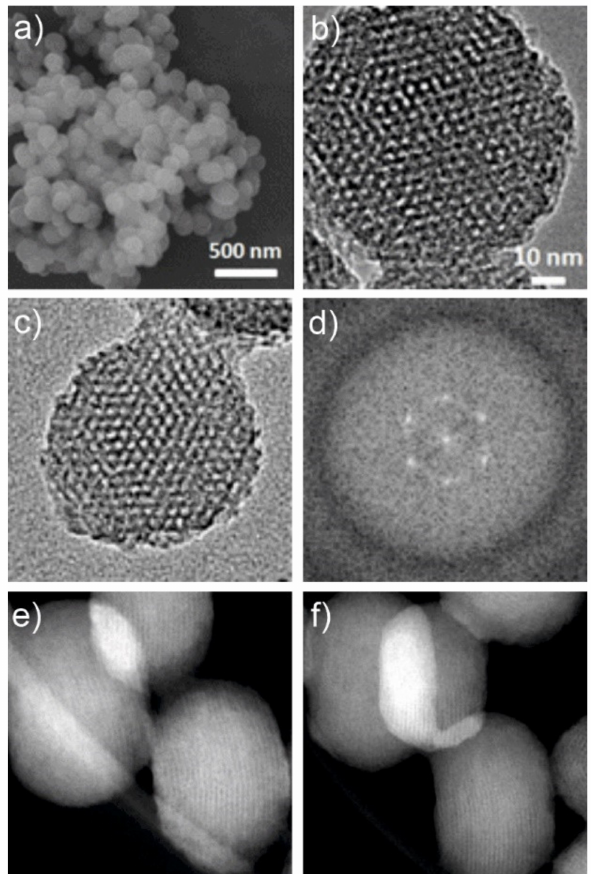
Figure 9. Characterization of hexagonal-symmetry MSNs (HMSNPs) by electron microscopy ( a ) SEM, ( b ) TEM, ( c ) HRTEM image, and ( d ) associated fast Fourier transform (FFT), ( e ), and ( f ) HAADF- STEM images obtained from different specimen orientations. Adapted from [144], Copyright 2014 SAGE